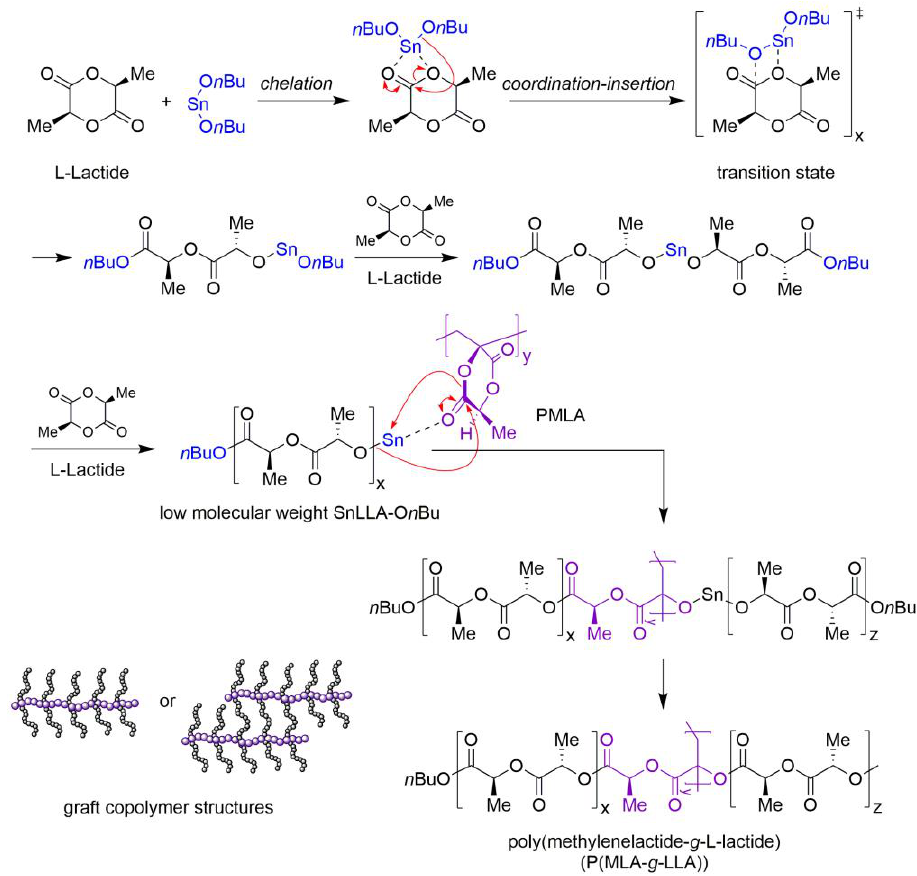
Scheme 4. Proposed mechanism for the synthesis of poly(methylenelactide- g -L-lactide), P(MLA- g